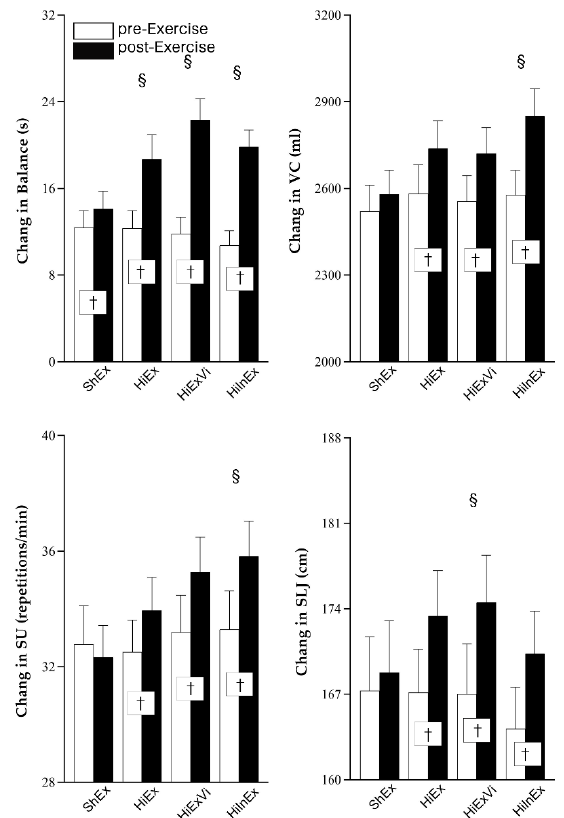
Figure 3. The change in balance function, sit up (SU), vital capacity (VC), and standing long jump (SLJ). ShEx—sham exercise; HiEx—high-impact exercise; HiExVi—high-impact exercise with various directions; HiInEx—high-intensity interval exercise. Data are presented as mean ± standard deviation (SD). † indicates that the difference between pre- and post-exercise is significant ( p < 0.05). § denotes that the difference in change magnitude is significant in HiEx, HiExVi, and HiInEx groups compared with ShEx group ( p < 0.05).